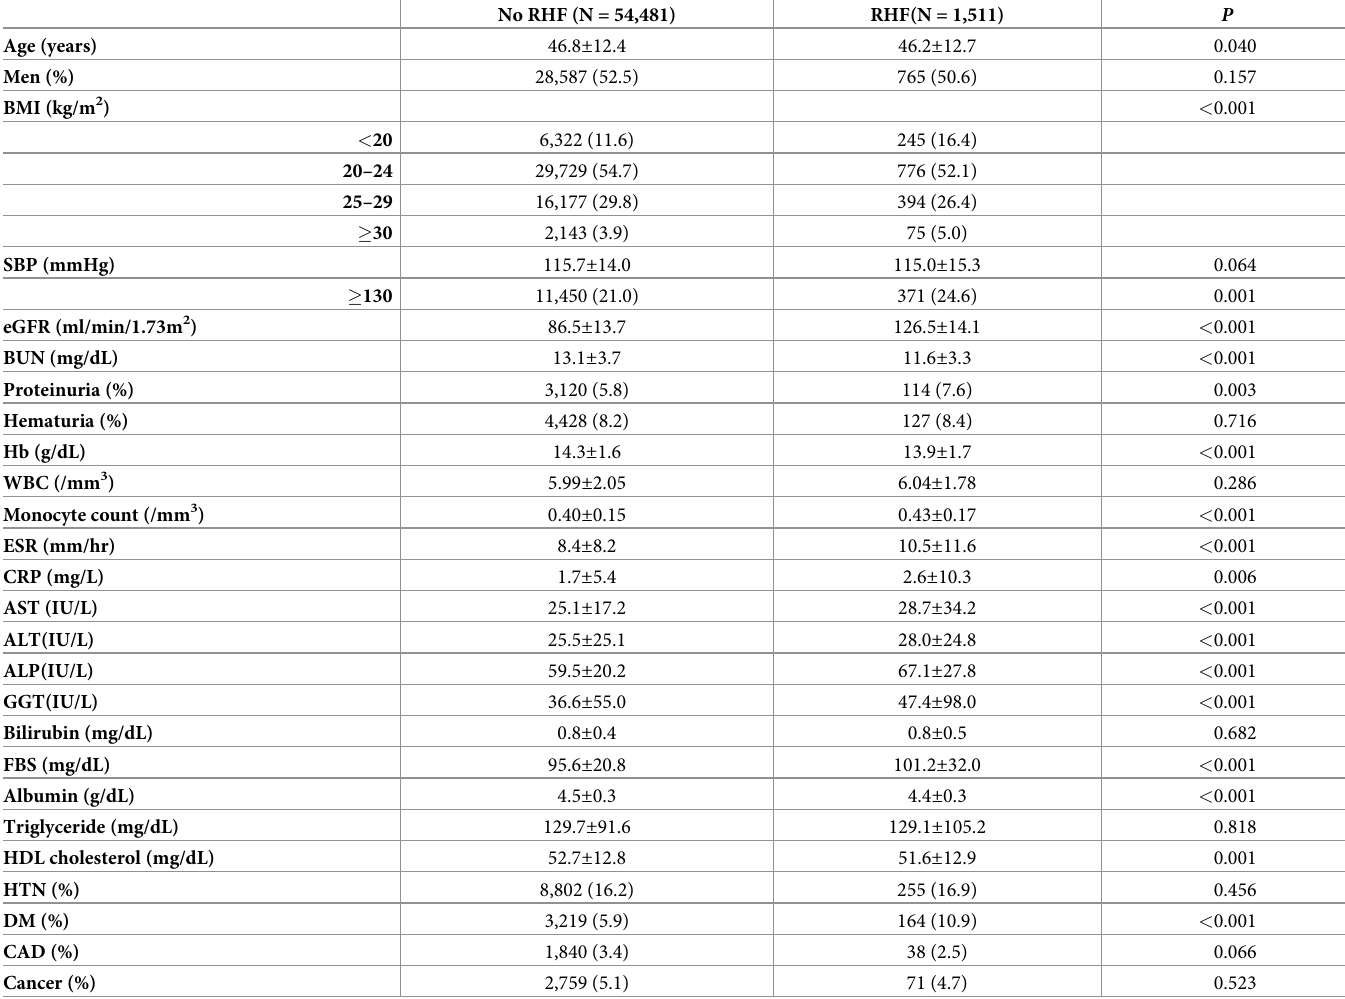
Table 1. Characteristics of patients with renal hyperfiltration